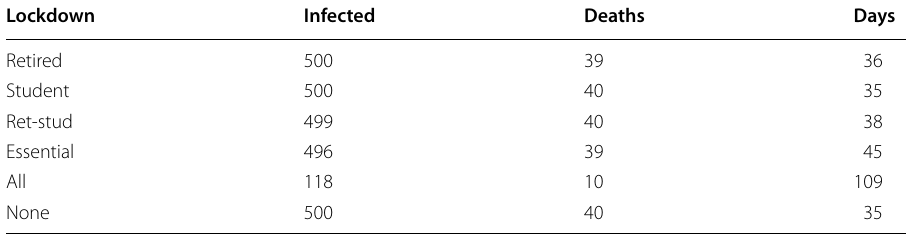
Table 1 Control, no security measures, no